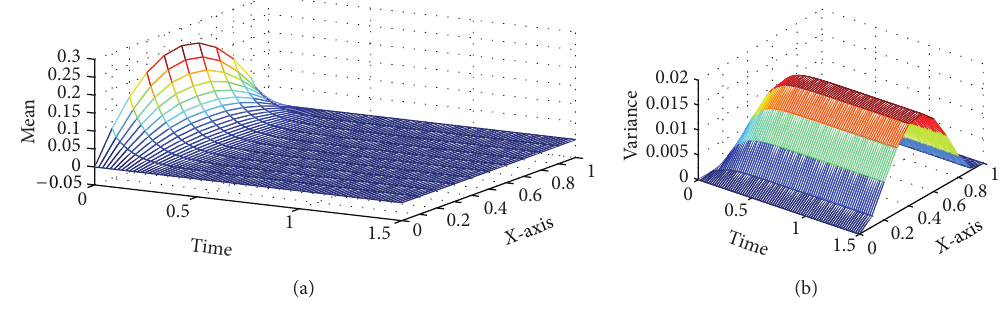
Figure 2: Solution mean (a) and variance (b) for 𝜆 =